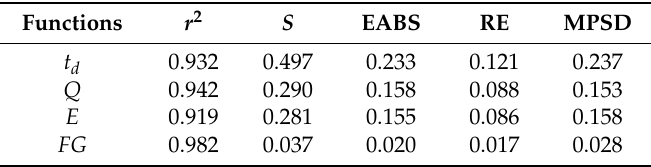
Table 2. Relevance of the numerical approximation.